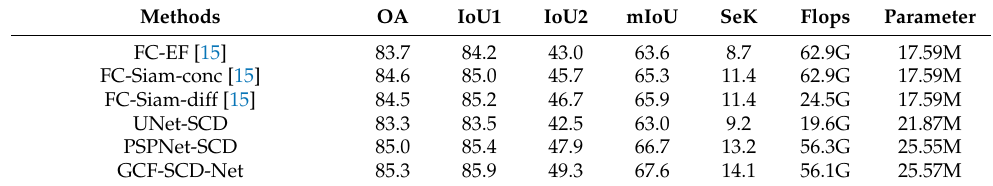
Table 4. Comparison with the state-of-the-art methods on the SECOND dataset (% for all except seK). Methods